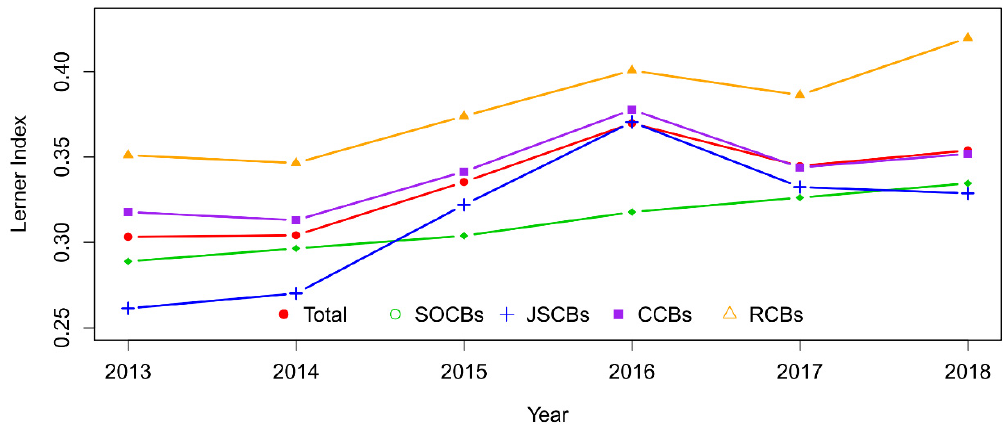
ff erent types of banks by